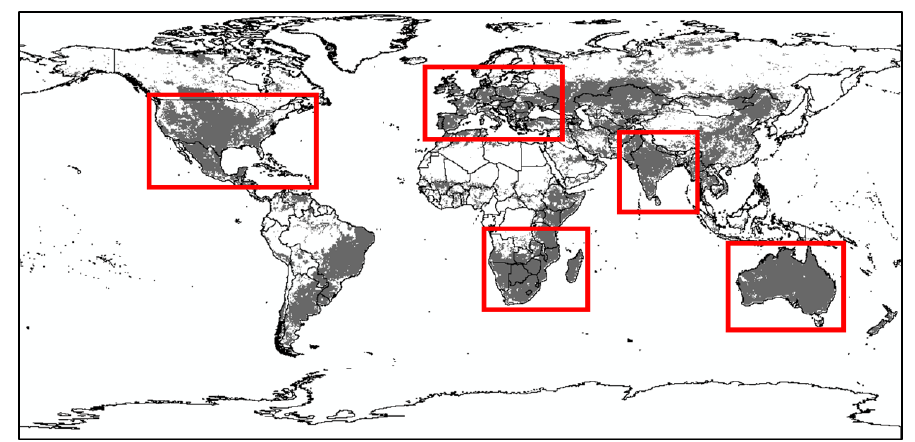
Figure 1. Map of the areas where all three models are positively significantly linearly correlated (cells in grey) according to the Student’s t test at p = 0.05. The boxes delimitate the macro-regions selected for the successive analyses. Table 1. Summary of the Pearson correlation coefficient values (average ± standard deviation) observed for all the regions. Comparison ALL NA EU SA IN AU LIS vs. LST 0.44 ± 0.09 0.41 ± 0.08 0.39 ± 0.07 0.48 ± 0.09 0.44 ± 0.07 0.50 ± 0.10 LIS vs. CCI 049 ± 0.10 0.47 ± 0.09 0.42 ± 0.08 0.48 ± 0.10 0.48 ± 0.08 0.58 ± 0.11 CCI vs. LST 0.56 ± 0.13 0.68 ±